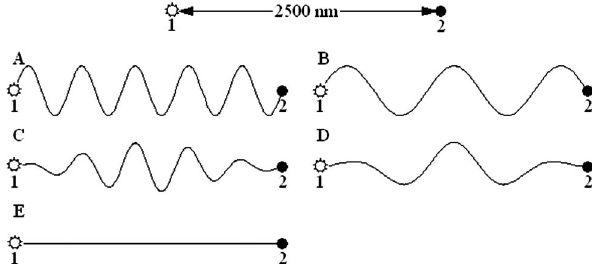
FIG. 6. An alternative version of question 4, taken from